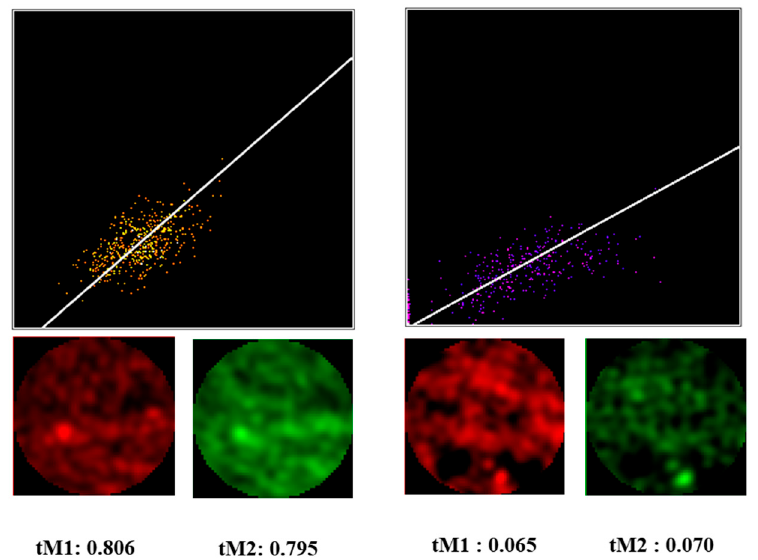
Figure 7. Colocalization of β - and γ -actin in the endothelial cell lamella: the Manders’ coefficient. Scatterplots of pixel intensity correlation reflect regions with high ( left ) and low ( right ) colocaliza- tion coefficients.